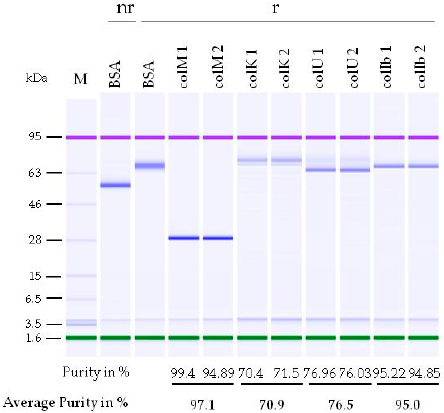
Figure 3. Capillary gel electrophoresis for evaluating the purity of the colicin preparations. One batch of lyophilized ColM, ColK, ColU, and ColIb was resuspended with H 2 O to a colicin concentration of 1 mg/mL and analyzed with an Agilent Protein 80 Kit (Agilent Technologies Deutschland, Waldbronn,